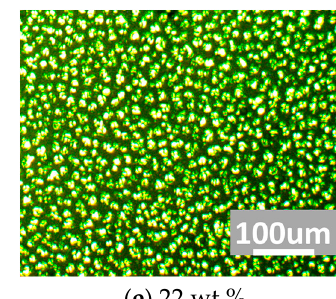
Figure 4. Transmission images after refilling the nematic LC into the polymer template with the polymer concentration of ( a ) 14 wt %; ( b ) 16 wt %; ( c ) 18 wt %; ( d ) 20 wt %; and ( e ) 22 wt %, respectively. Table 1. Precursors with different polymer concentrations.